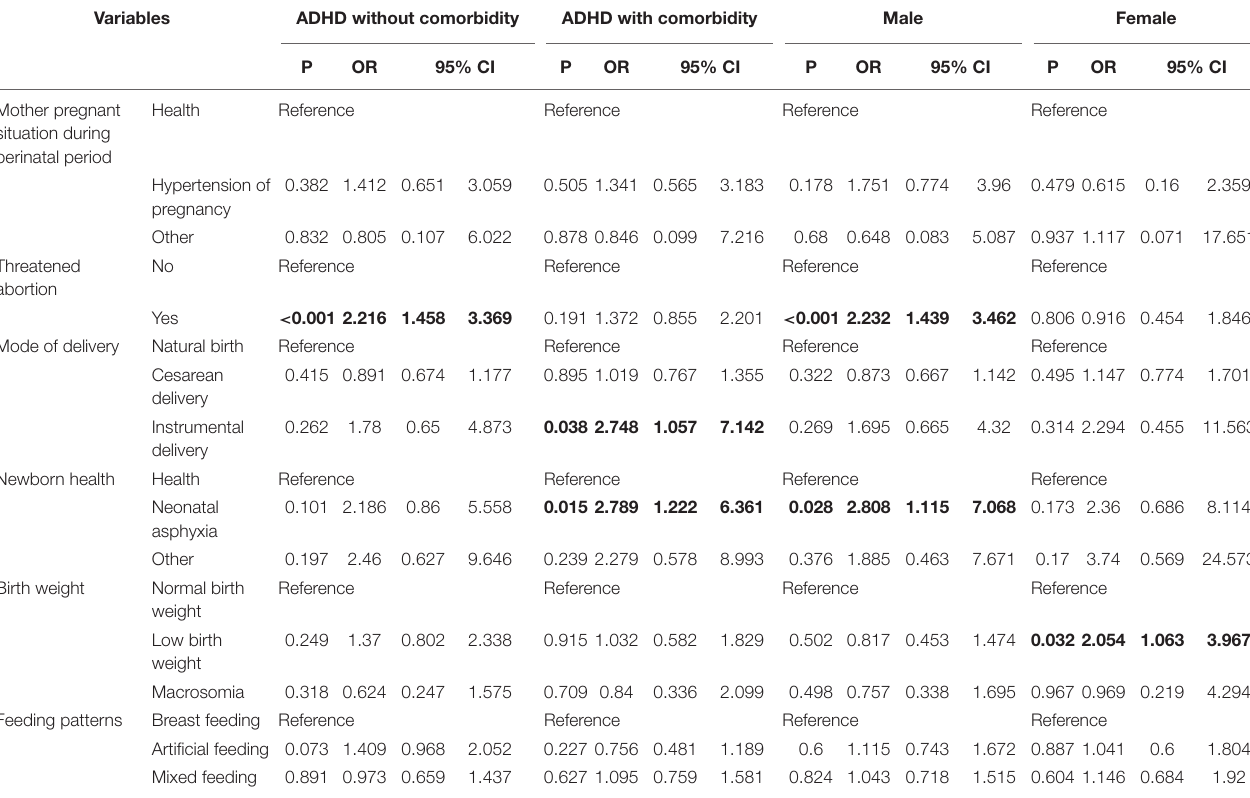
TABLE 4 | Results of multivariate analysis (logistic regression analysis) for the subgroup of ADHD with comorbidity, disaggregated by gender in the second model. Variables ADHD without comorbidity ADHD with